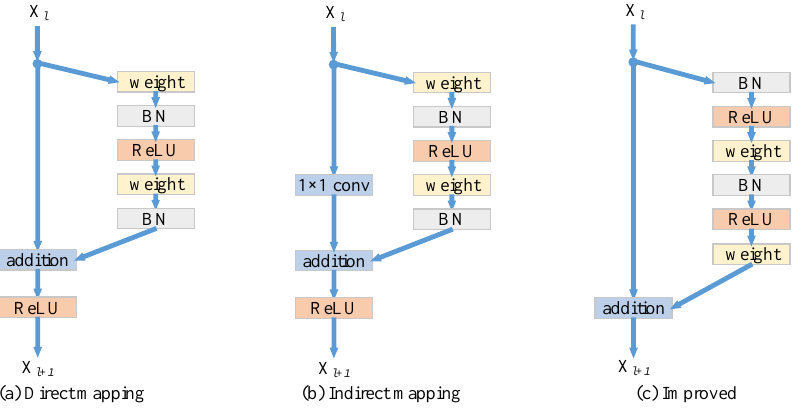
Figure 2. Three different residual modules: ( a ) Direct mapping residual module; ( b ) indirect mapping residual module; ( c ) improved residual